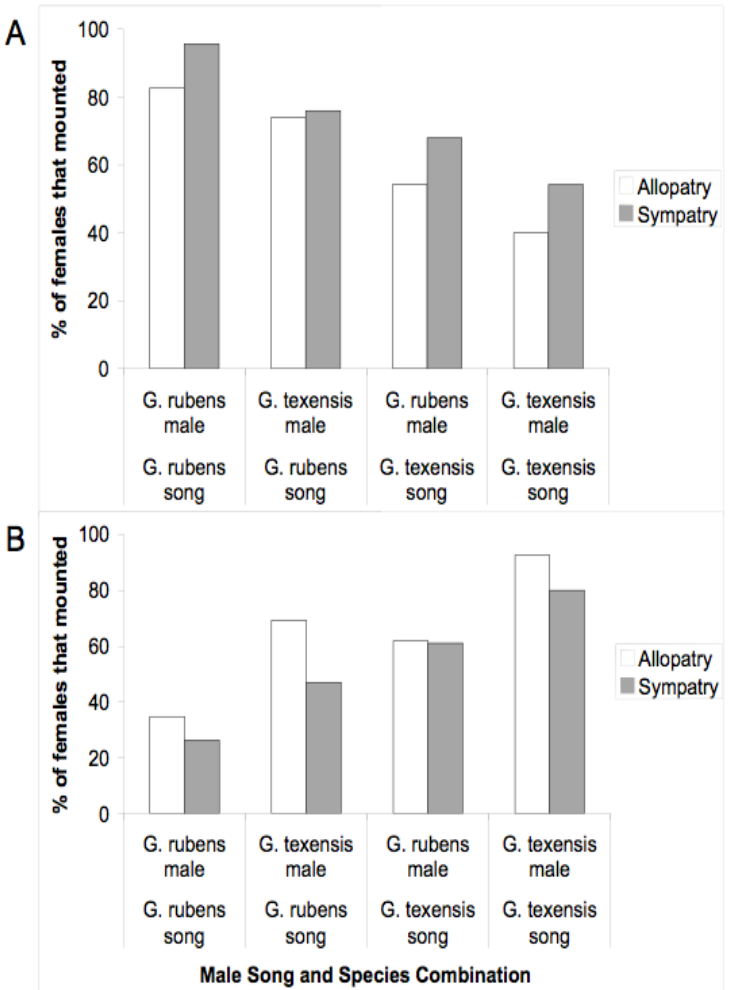
Figure 3. Rates of female acceptance of male courtship when courtship song is experimentally decoupled from male species identity; muted males were accompanied by the species-average courtship song indicated. There were separate statistically significant effects of both male species identity and courtship song played, but no significant effect of female allopatry or sympatry for both G. rubens females (Figure 3a) and G. texensis females (Figure 3b). Figure modified from Gray